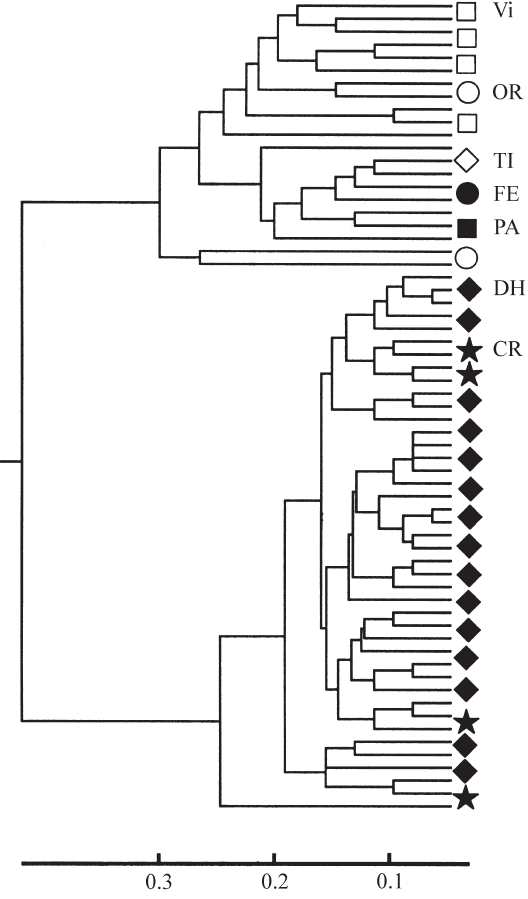
Figure 2 - Phenogram of overall molecular similarity of Hoplias malabaricus individuals in the Rio Doce basin. Two clusters are evident: on top, riverine samples (VI and OR) together with lacustrine samples TI, FE, and PA; the second group is formed by the lacustrine samples DH and CR. Similarity indices are indicated.